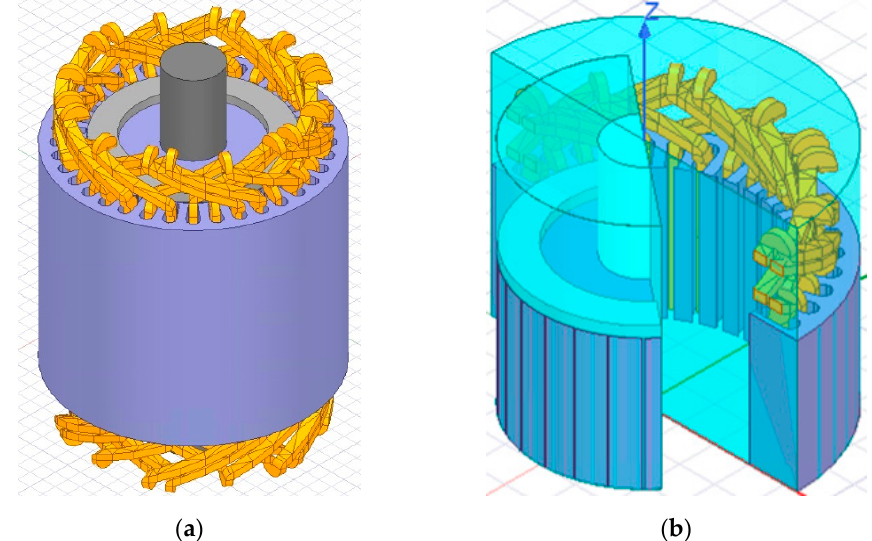
Figure 1. ( a ) 3D induction motor model; ( b ) details of stator, rotational band, and boundary conditions.